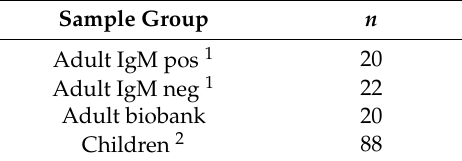
Table 1. Summary of sample